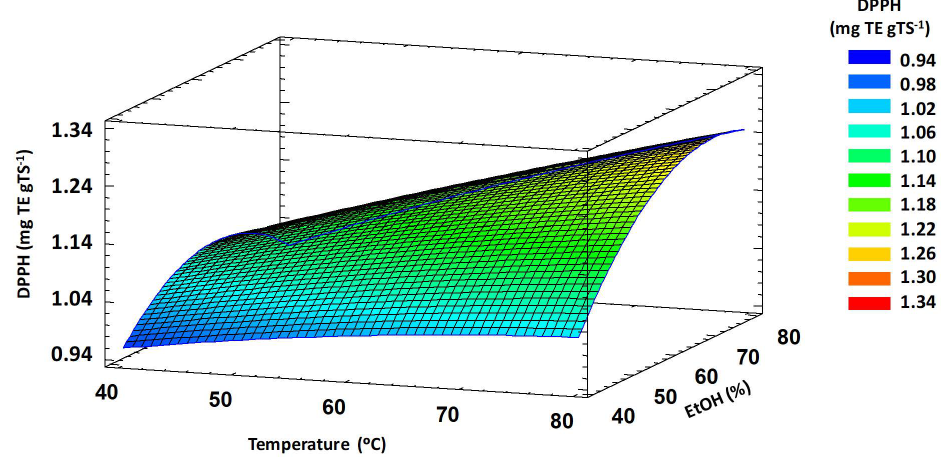
Figure 1. Response surface plot showing significant interaction of extraction temperature vs. ethanol concentration on DPPH antioxidant activity of TSE obtained by MAE. DPPH: 2,2-diphenyl-1- picrylhydrazyl, TSE: tomato seed extracts, MAE: microwave-assisted